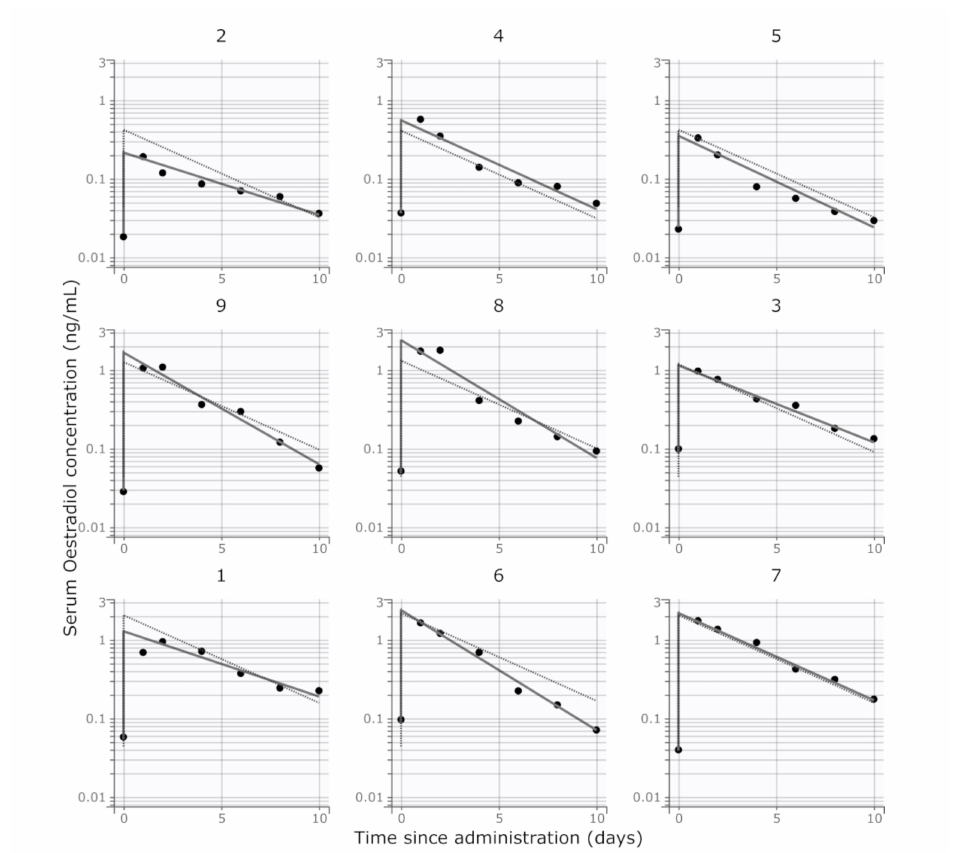
Figure 2. Individual goodness-of-fit plots for the estradiol-17 β concentrations after intramuscular administration of estradiol cypionate. Subjects 2, 4, and 5: nominal dose 0.1 mg / kg (of estradiol cypionate); subjects 9, 8, and 3: nominal dose 0.3 mg / kg; subjects 1, 6, and 7: nominal dose 0.5 mg / kg. Points are the individual observations. Solid lines are the individual predictions. Dashed (light grey) lines are the population predictions (fixed e ff ects